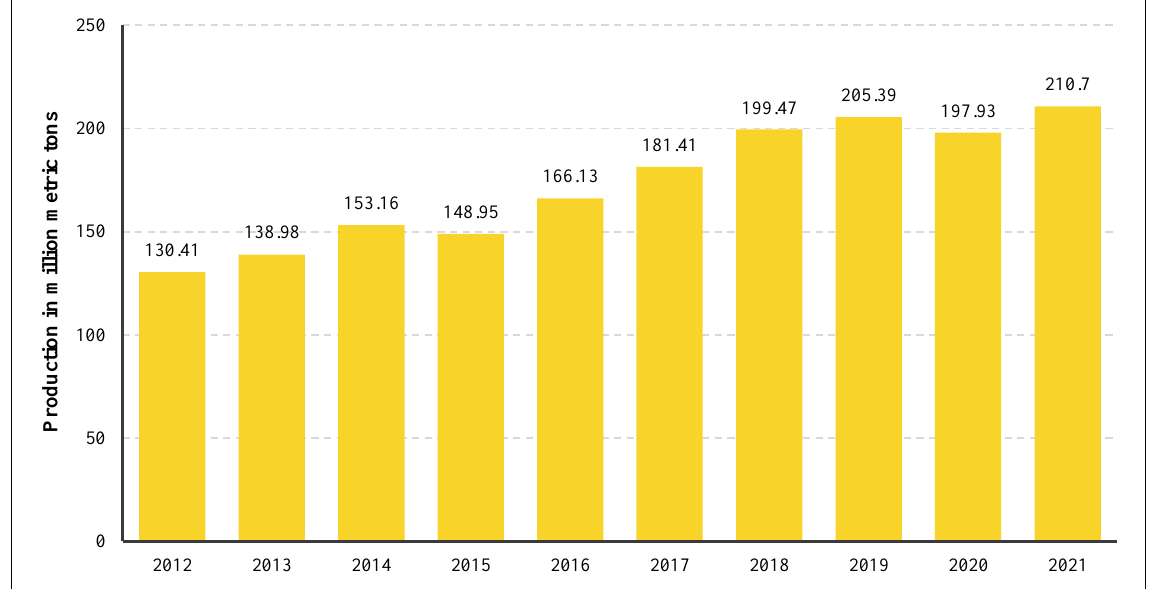
Figure 8. Russia’s coal exports